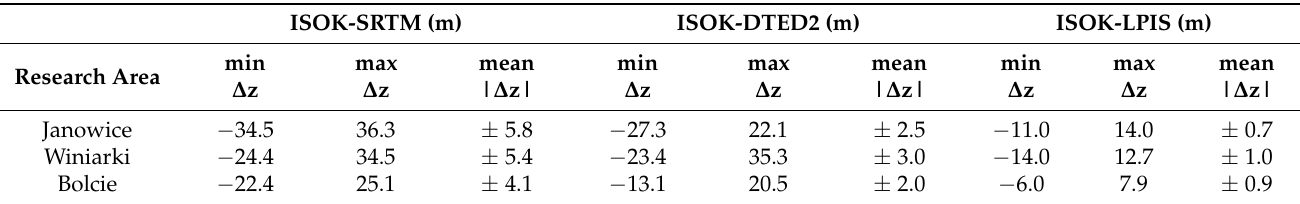
Table 5. Comparison of the differences in the elevation values from DTM of lower accuracy and detail (SRTM, DTED2 and LPIS) to ISOK (minimum, maximum and mean of the absolute value | ∆ z| of the